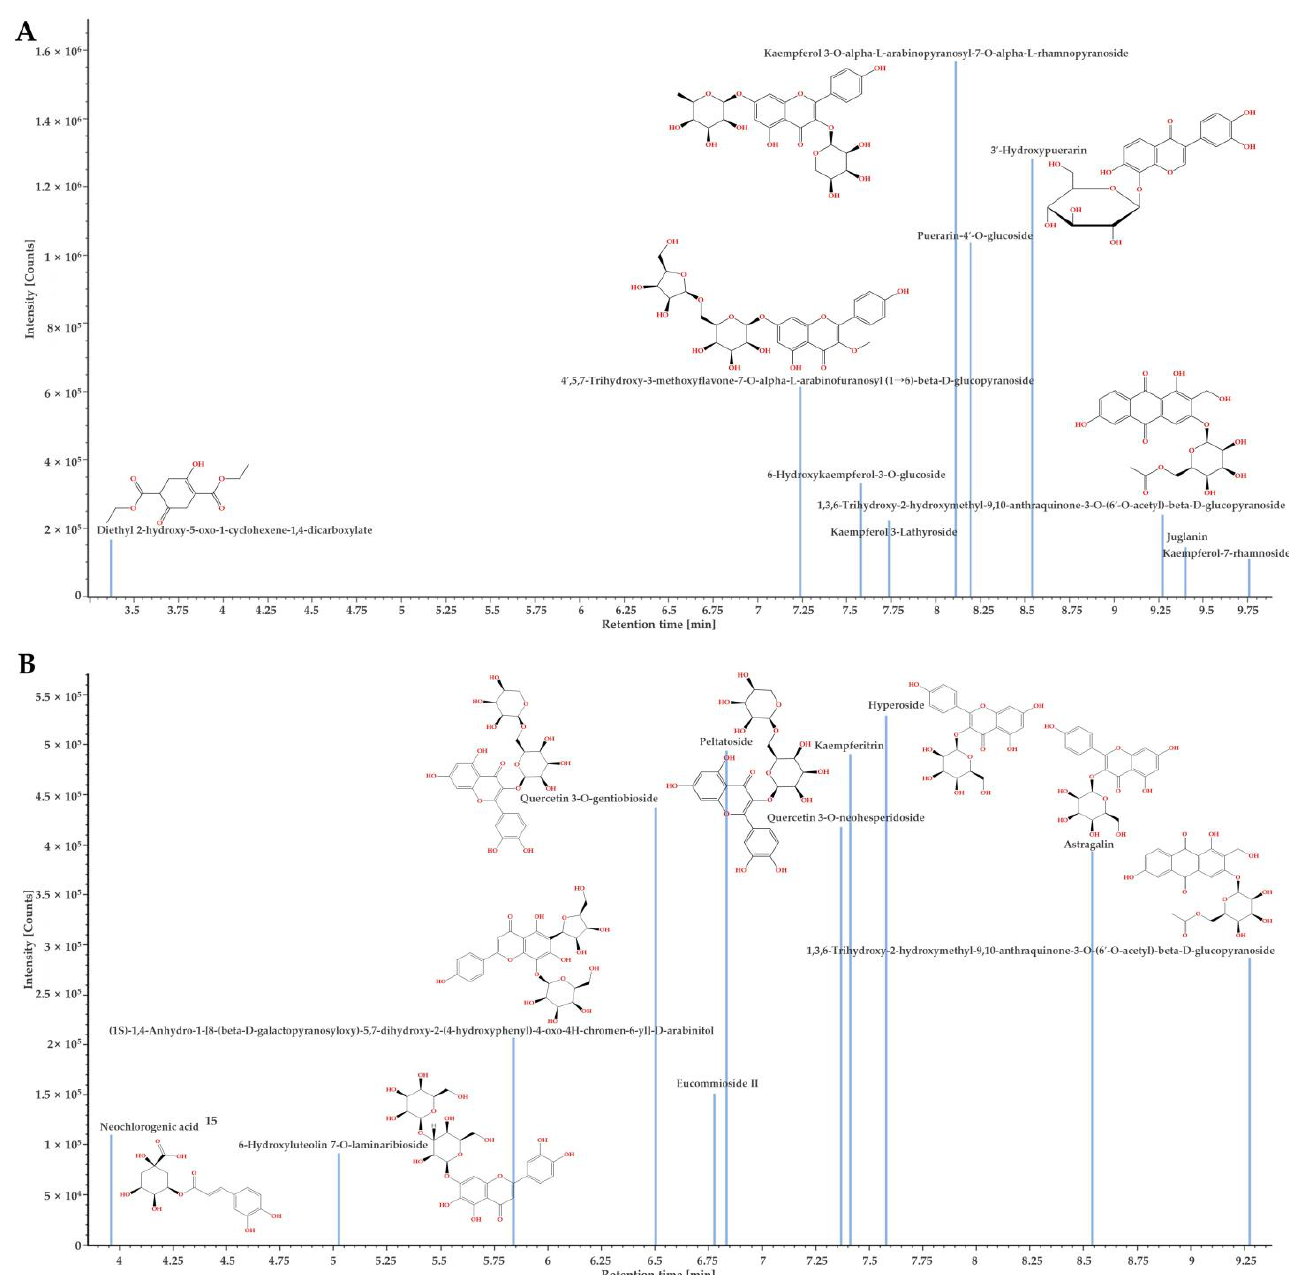
Figure 2. The confirmed component plot of UPLC-QTOF-MS analysis of D. lacera ( A ), and D. bissetiana ( B ) extracts.